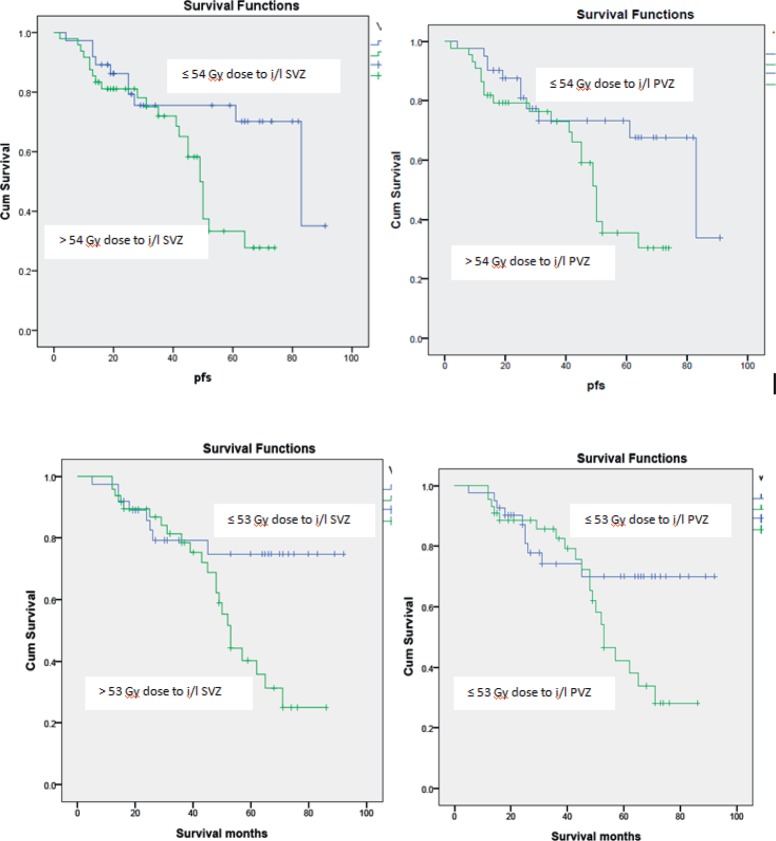
Kaplan–Meier estimates for progression free survival and overall survival.